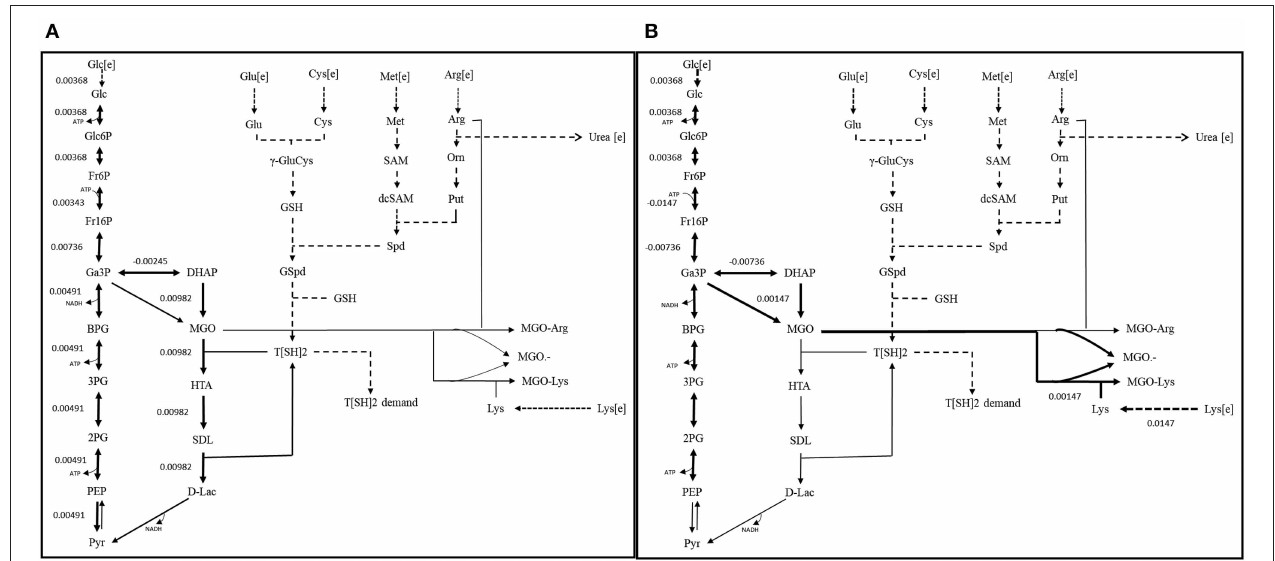
FIGURE 9 | Reaction fluxes for (A) scenario 1 (Functional GLOI), and (B) scenario 2 (Non-functional GLOI). The depicted scenarios are illustrating the flow of flux for the objective function (OF). The simulation was performed for the production of pyruvate (from glycolysis and glyoxalase pathway) and role of MGO in producing AGEs (MGO-Arg and MGO-Lys) and MGO• free radical. Solid thick black arrows represent the direction of main flux flow through the model. Gray arrows are an indication − of undetermined (zero) flux through the respective reaction. Dotted arrows represent the transport of the